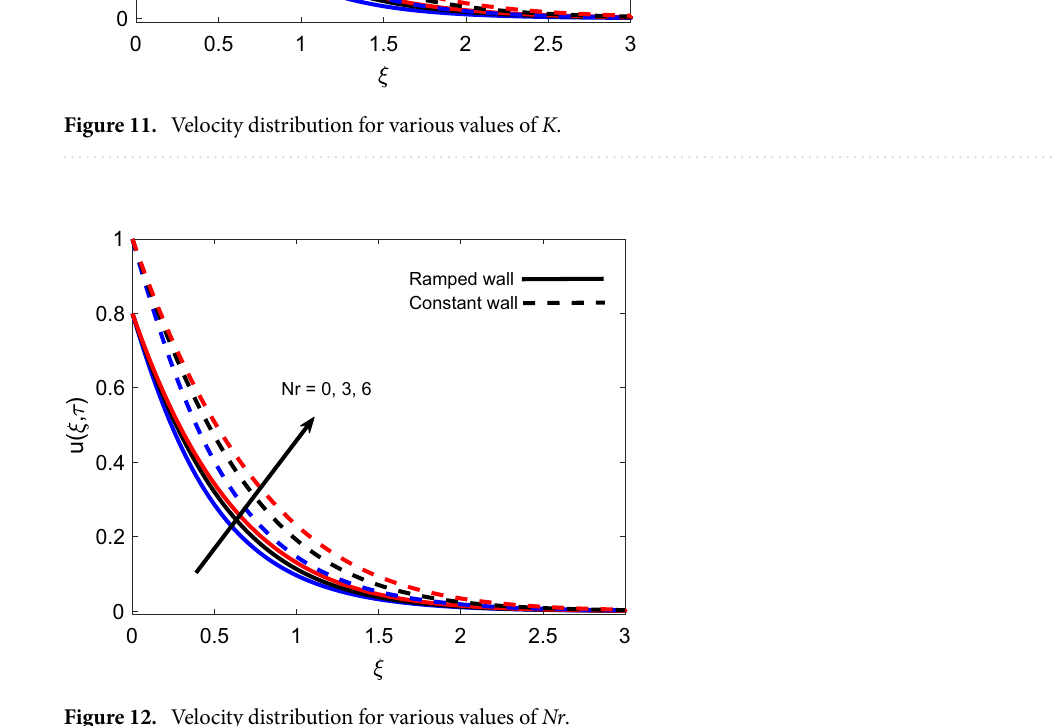
Figure 12. Velocity distribution for various values of Nr